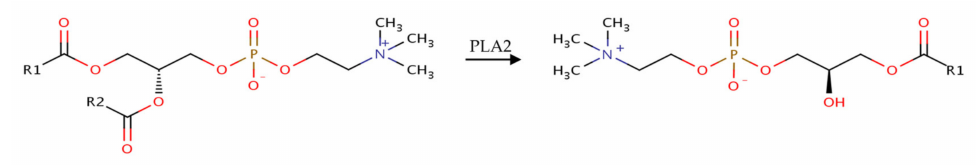
Figure 1. Biochemical modification of native phosphatidylcholine (PC).